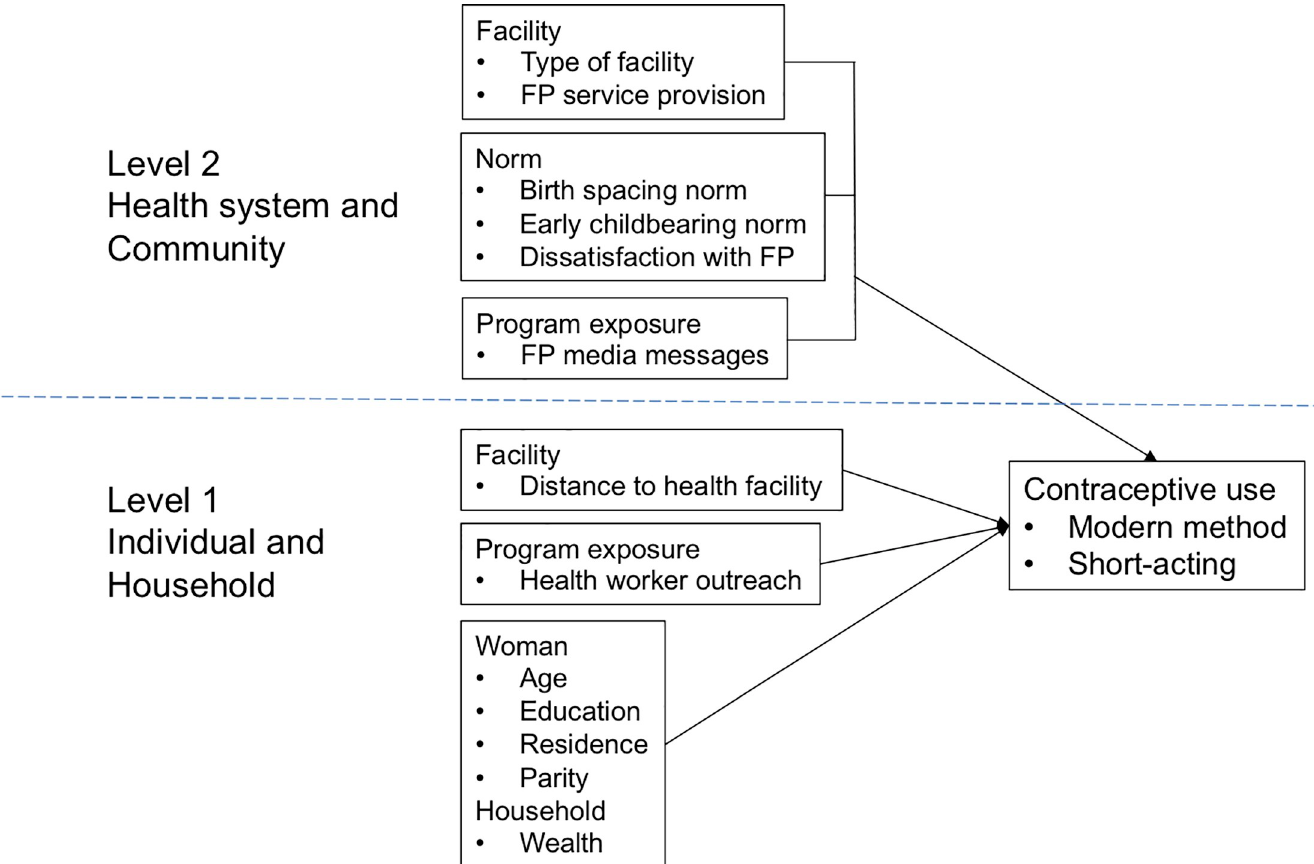
Fig 1. Multi-level framework of factors influencing individual contraceptive practice. Reprinted from Paek et al under a CC BY license, with permission from Paek, original copyright 2008.